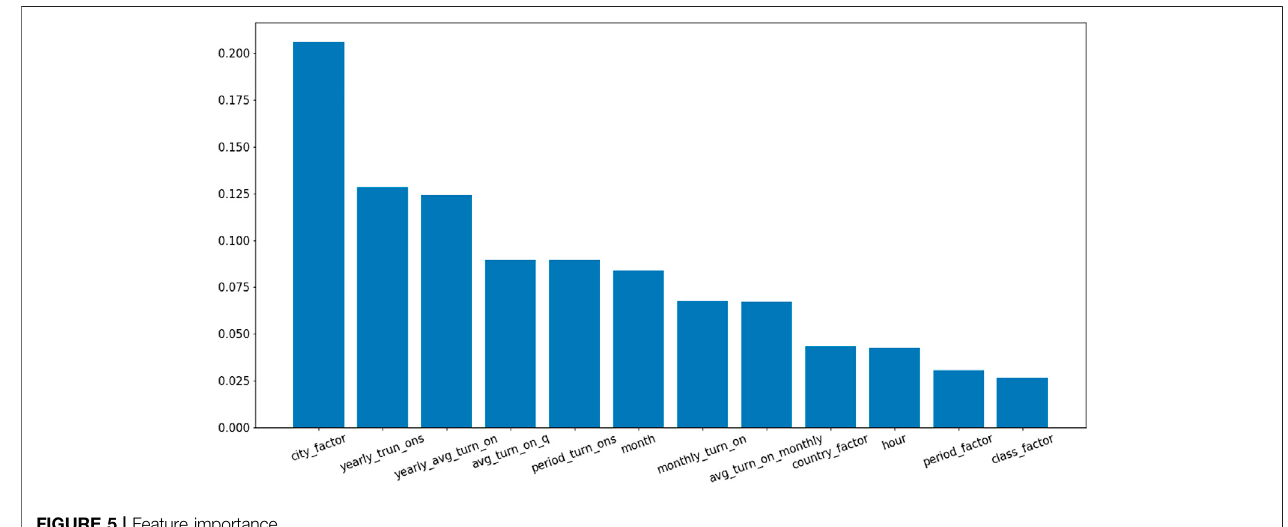
FIGURE 5 | Feature importance.